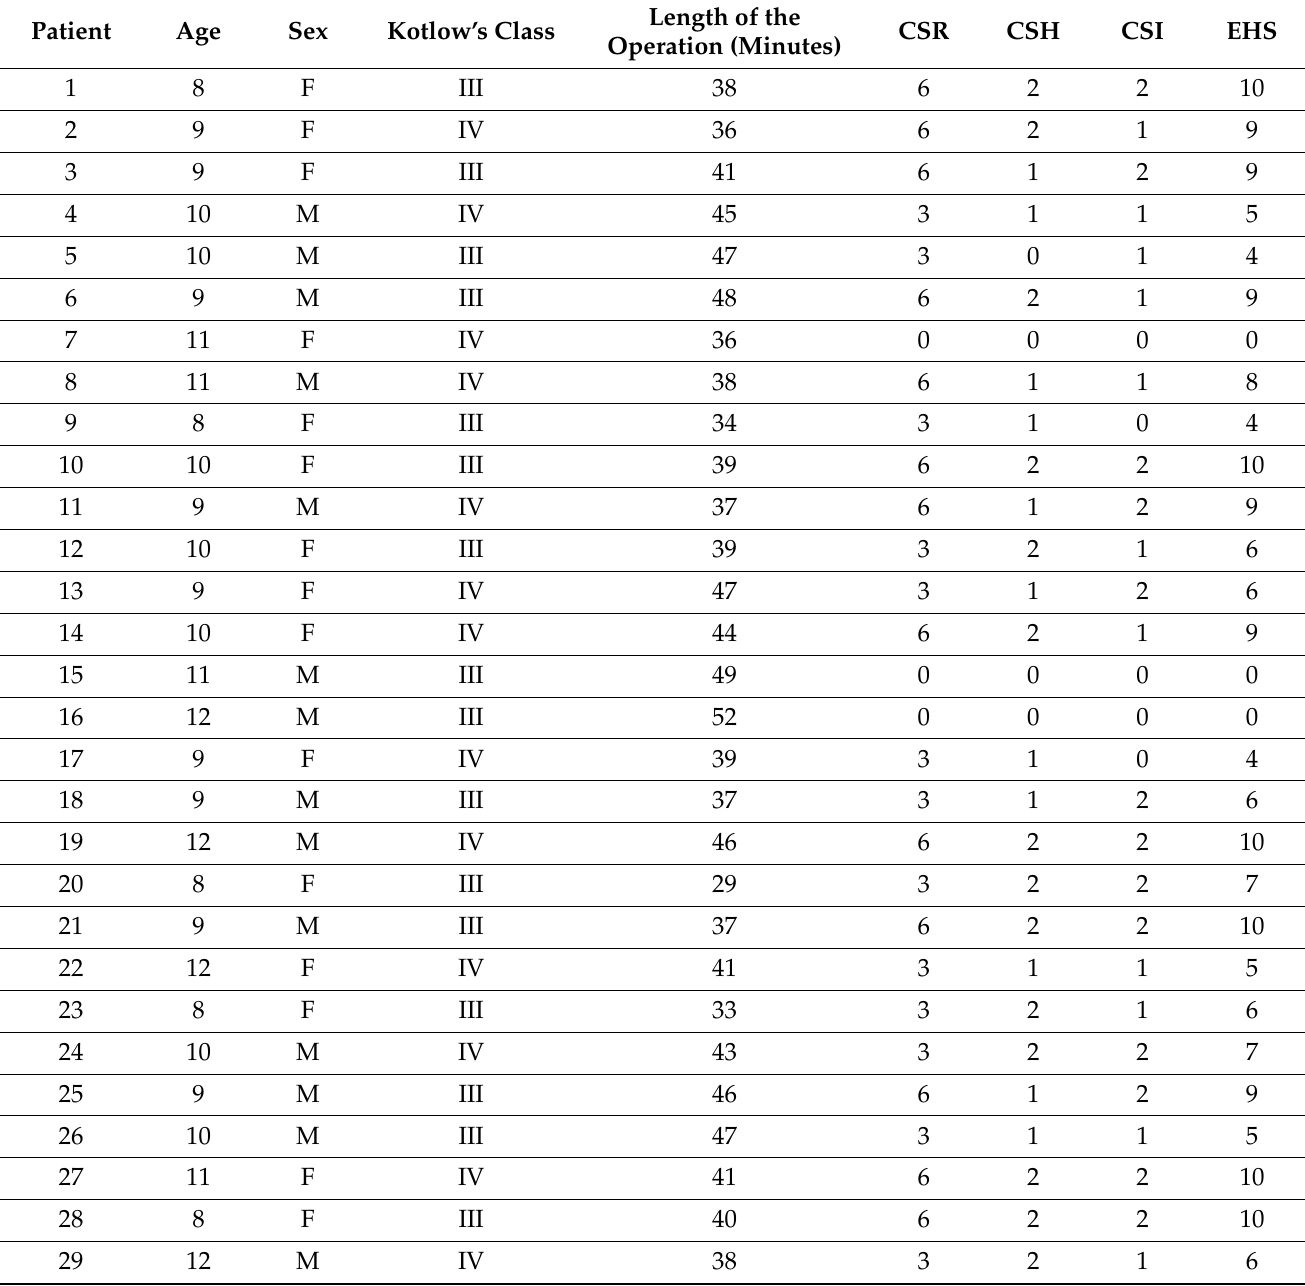
Table 2. Clinically recorded EHS parameters for patients of Group